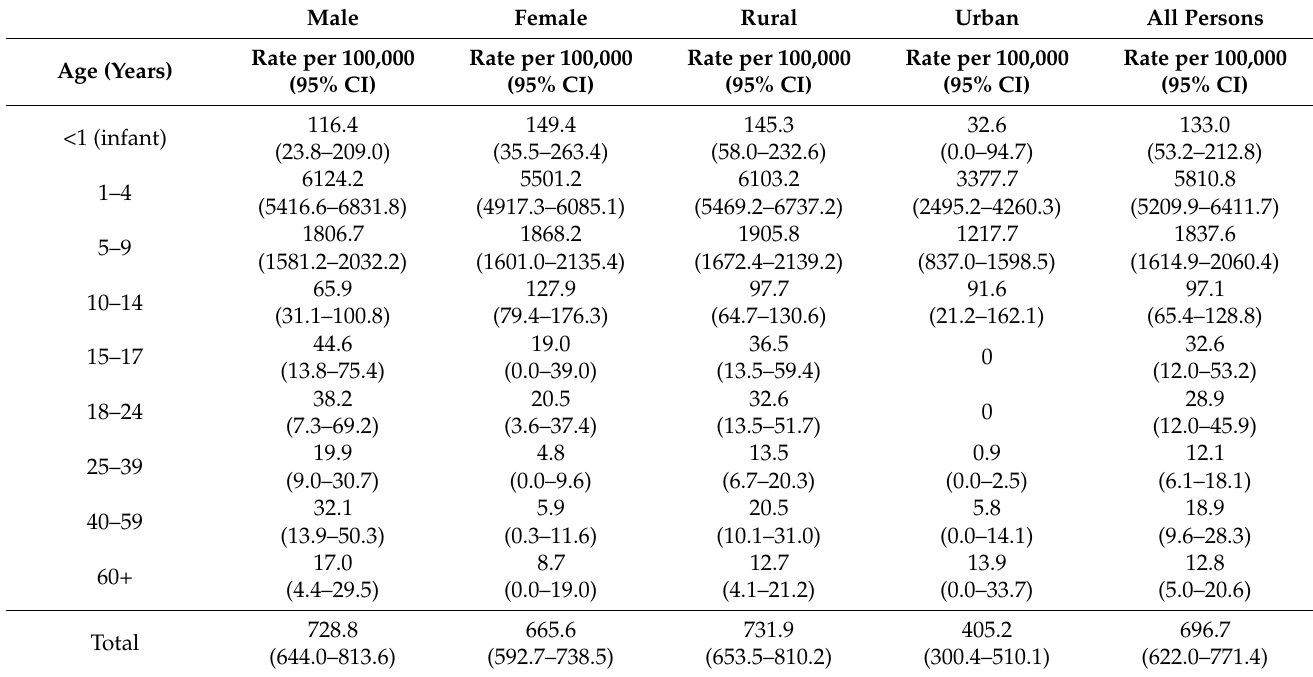
Table 2. Non- fatal drowning event rates by age, sex, and rurality in the Barishal Division, Bangladesh. Male Female Rural Urban